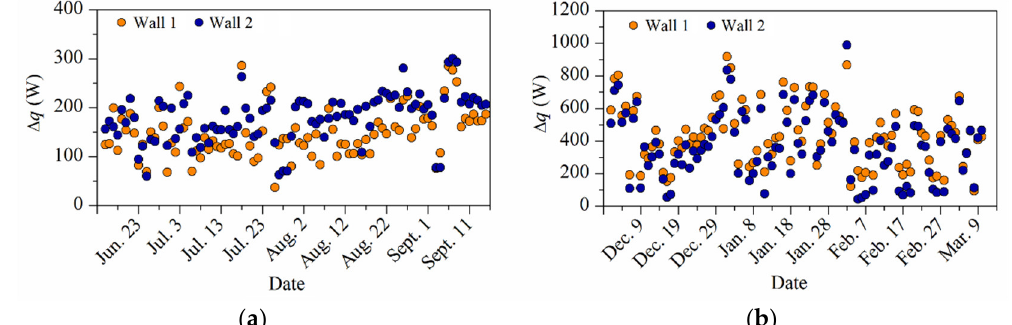
Figure 11. The peak and valley load difference of ACS for different insulation form; ( a ) in cooling season; ( b ) in heating season.